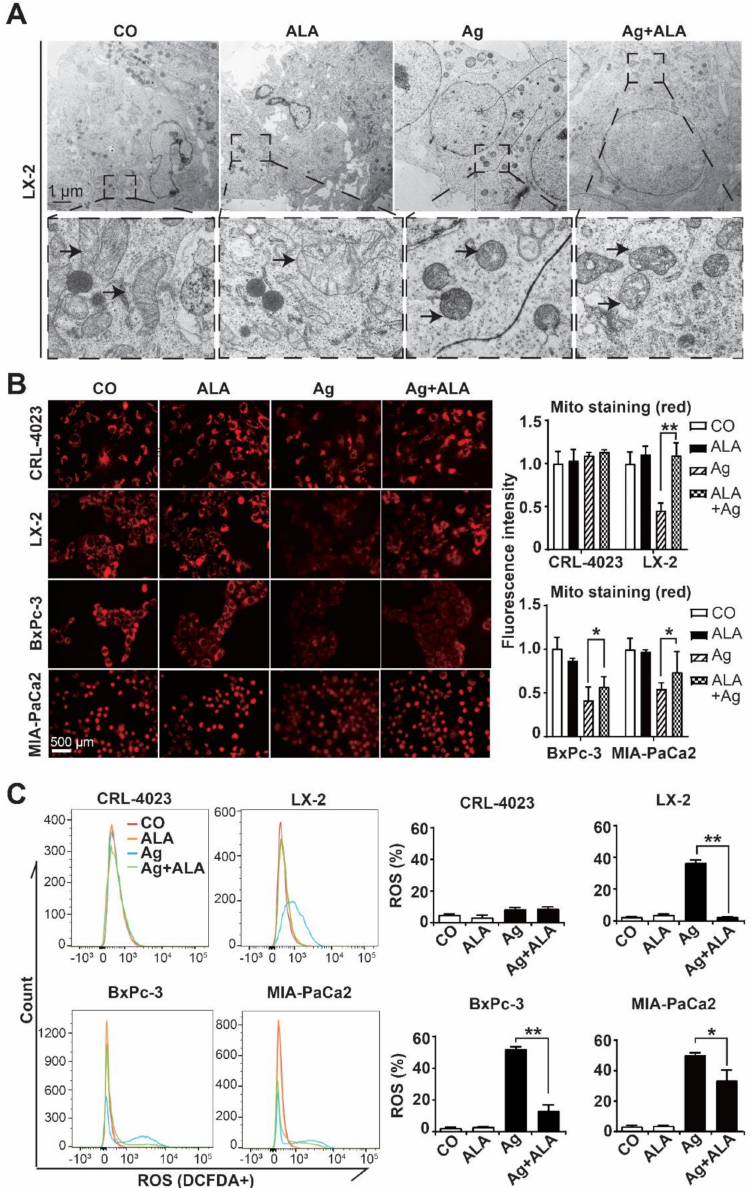
Figure 4. α -Lipoic acid rescues AgNP-induced mitochondrial damage and ROS formation in non- malignant but only partially rescues in PDAC cells. ( A ) LX-2 cells at a concentration of 5 × 10 3 in 100 µ L cell culture medium per well were seeded in 96-well plates. Twenty-four hours later, the cells were treated by adding 10 µ L of a 14 ppm AgNP stock solution to the cell culture medium, resulting in a final working concentration of 1.4 ppm AgNPs. Likewise, 0.5 µ L of a 200 mM α -lipoic acid (ALA) stock solution was added, resulting in a final concentration of 1 mM, as indicated. Control cells were left untreated (CO). Twenty-four hours later, the cells were prepared for TEM, followed by ultramicroscopic evaluation. Representative images are shown above, and 30 × magnifications are shown below. The scale bar indicates 1 µ m. The arrows mark the mitochondria. ( B ) CRL-4023, LX-2, BxPc-3 and MIA-PaCa2 at a concentration of 5 × 10 4 in a 1 mL cell culture medium per well were seeded in 24-well plates. Twenty-four hours later, the cells were incubated in a 1 mL medium with 1.4 ppm AgNPs w and w/o 1 mM α -lipoic acid (ALA) at final concentrations or were left untreated in the control (CO). Twenty-four hours later, the cells were stained by adding 2 µ L of the mitochondria-specific red fluorescent dye CytoPainter to the cell culture medium. After half an hour, 10 vision fields were randomly selected from each group and examined using a Leica DMRB fluorescence microscope at 400 × magnification. Representative images are shown on the left, and